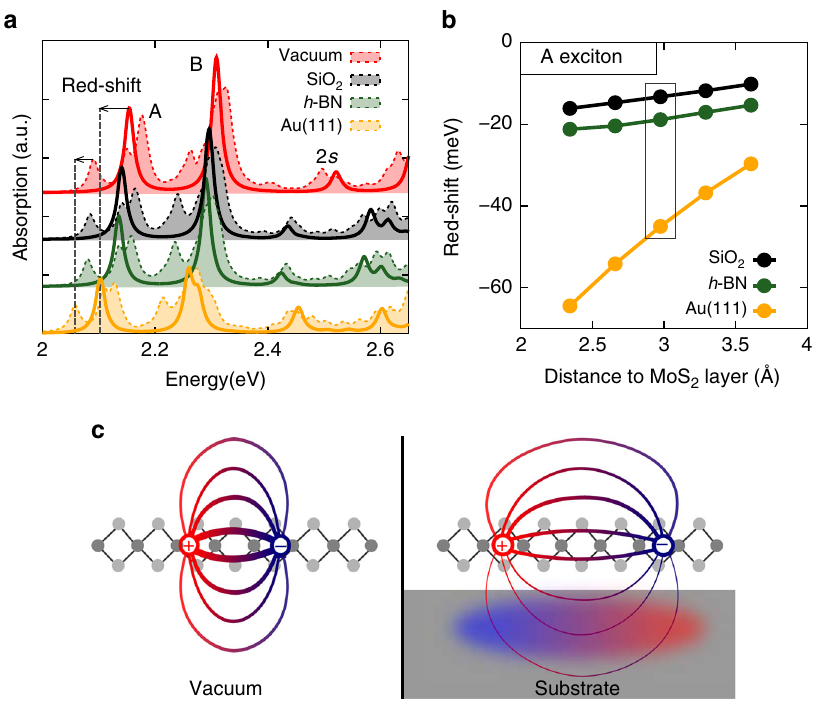
Fig.3 Red-shift of optical transitions due to substrate screening. a Exciton (solid lines) and negative trion (dashed and fi lled lines) absorption spectra of an MoS 2 monolayer in vacuum and on different substrates. Both spectra stem from a single calculation. The arrows indicate the red-shift in going from MoS 2 in vacuum to a gold substrate. All substrates are placed at a distance of 3 Å and have a well-converged thickness of about 10 Å (i.e., increasing the substrate thickness by another layer of ~2 Å leads to an excitation shift of less than 0.5 meV). An arti fi cial broadening of 0.01 eV is used. b Red-shift of the A exciton energy as a function of the distance to the substrate (using extrapolated values of N → ∞ in the k -mesh). The box marks the distance used in a . c Schematically illustration of a bound electron – hole pair in vacuum and on a substrate, where the Coulomb interaction is screened and the substrate is polarized